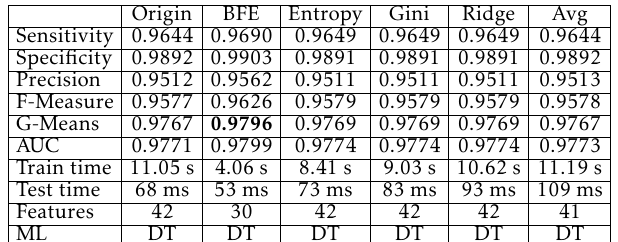
Table 30. Compare GR-BFE with other algorithms on FUZZERS attacks.